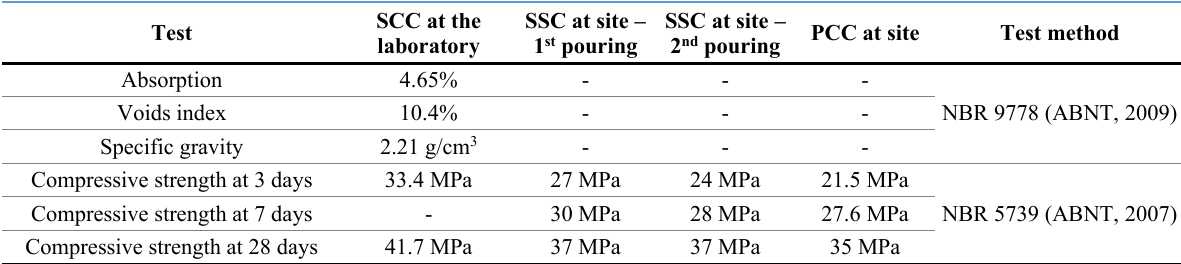
Table 7. Result of SCC tests in the hardened